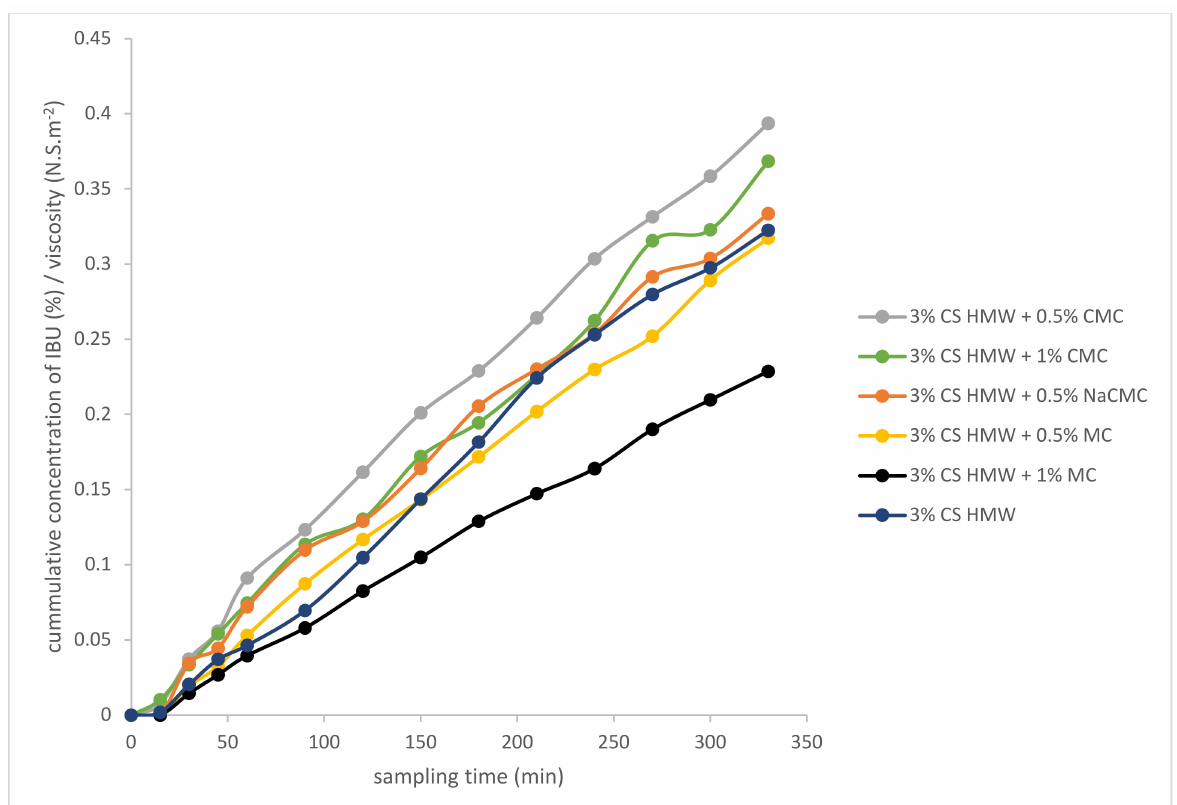
Figure 8. The cumulative amount of IBU released from chosen combinations of hydrogels in time, related to